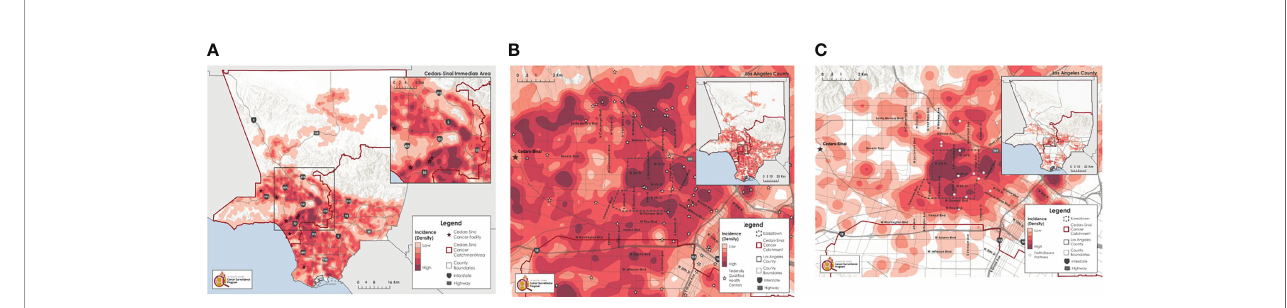
FIGURE 4 | (A) All race/ethnicity groups, females, all ages, 2000-2017*. (B) Focus on Koreatown, all race/ethnicity groups, females, all ages, 2000-2017*. (C) Focus on Koreatown, Korean, females, all